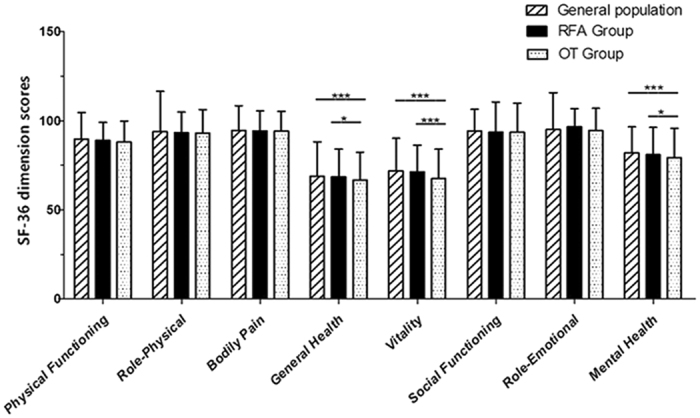
Graph shows the SF-36 dimension scores of the propensity score matched patients treated with radiofrequency ablation (RFA) or open thyroidectomy (OT) at 6 months follow up, together with those for the general population sample13.*P < 0.05,***P < 0.001.